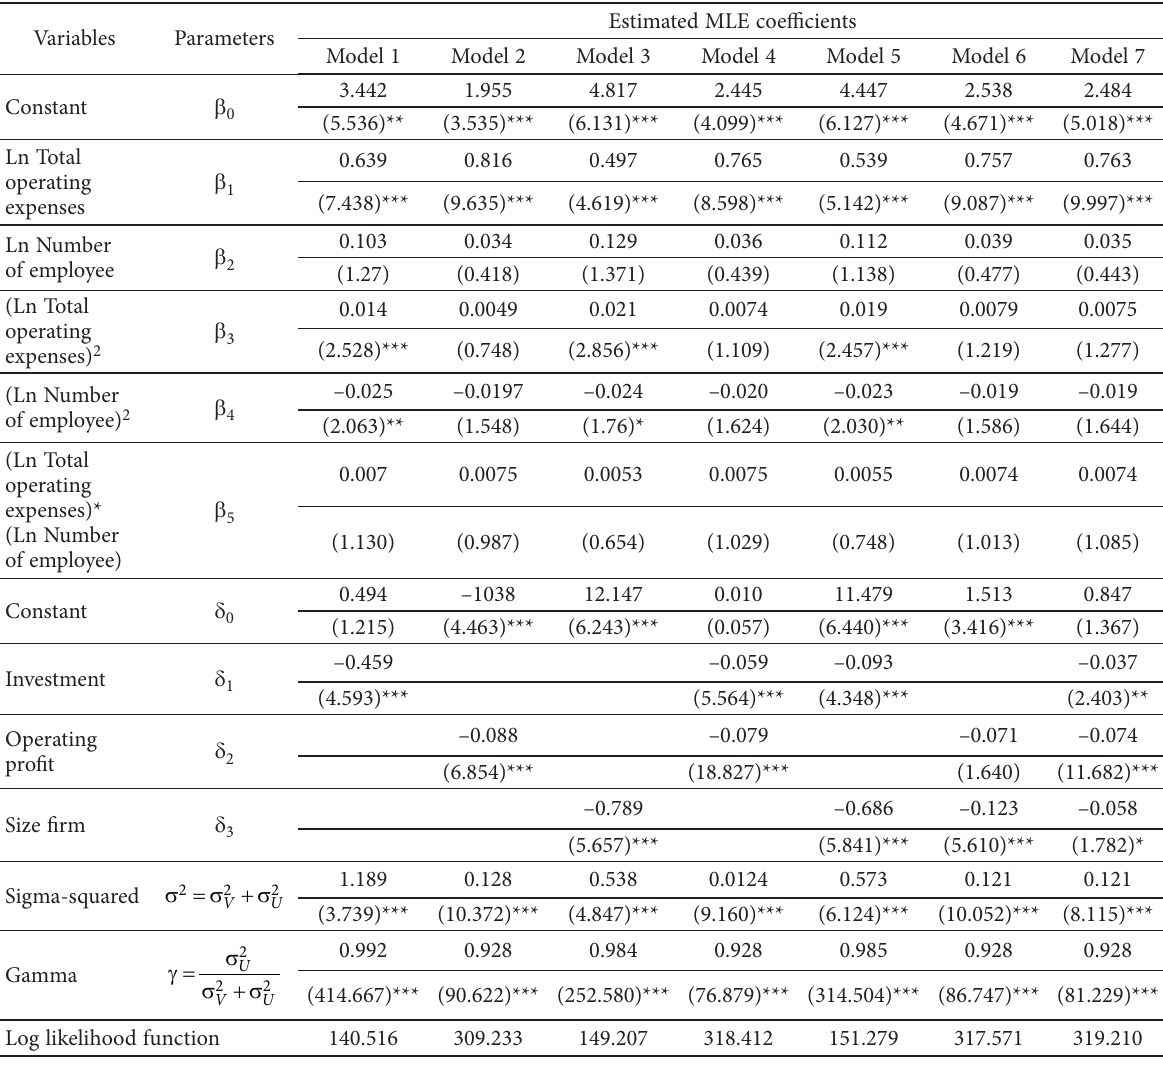
Table 3. Estimated parameters of the translog SFA production